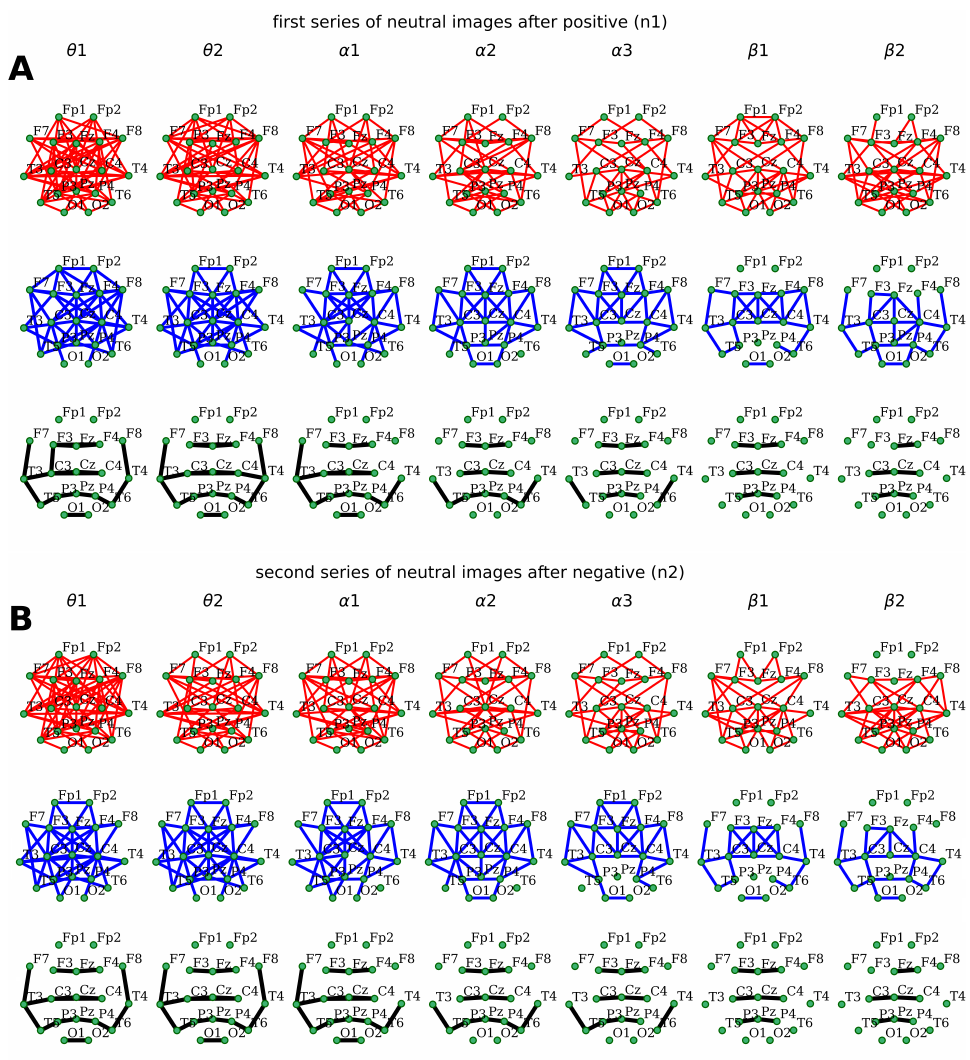
Figure 4. Topographical maps of coherent connections of different strength (red—0.3 < K < 0.5, blue—0.5 < K < 0.7, black—0.7 < K < 1.0) within EEG sub-bands during emotional facial perception: reaction to the first set of neutral faces after positive faces ( A ); reaction to the second set of neutral faces after negative faces ( B